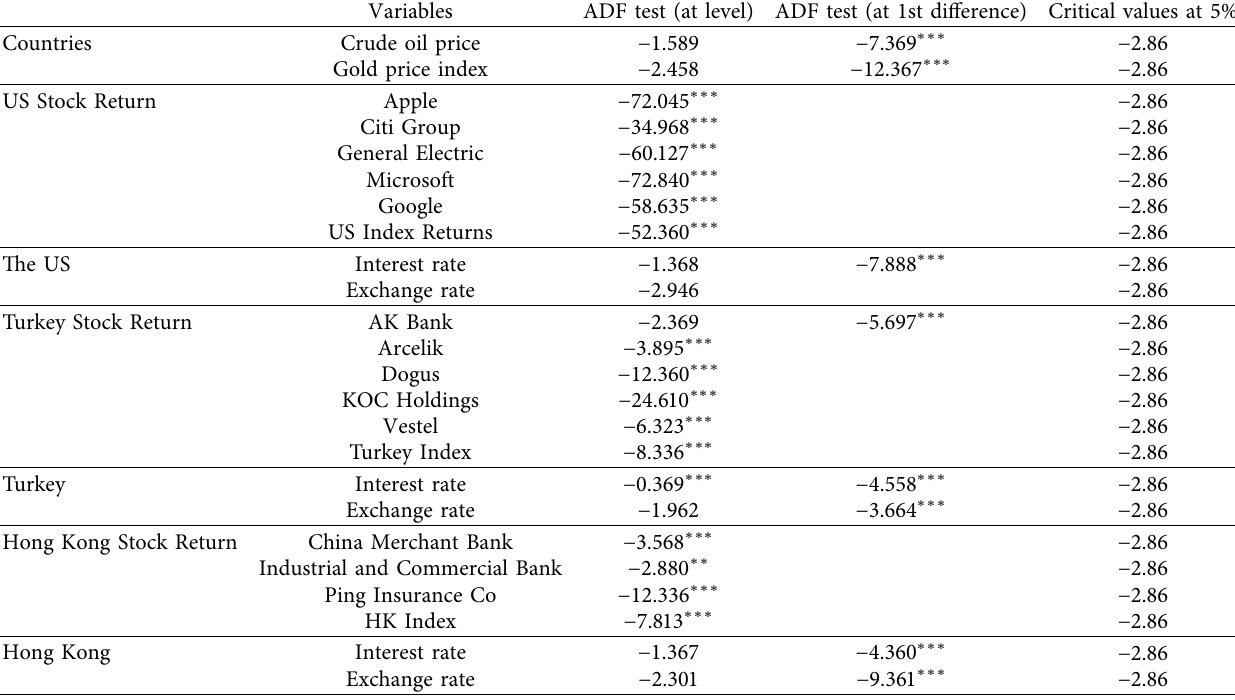
Table 5: Unit rate test of different countries.